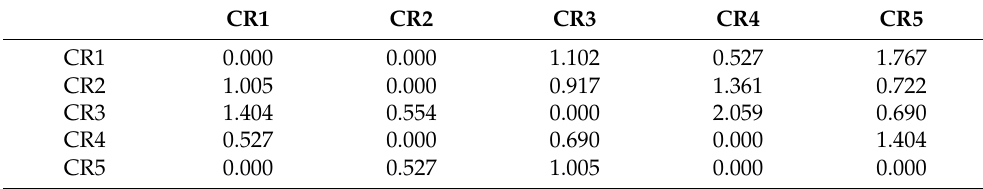
Table 7. Initial direct relationship matrix of CRs.